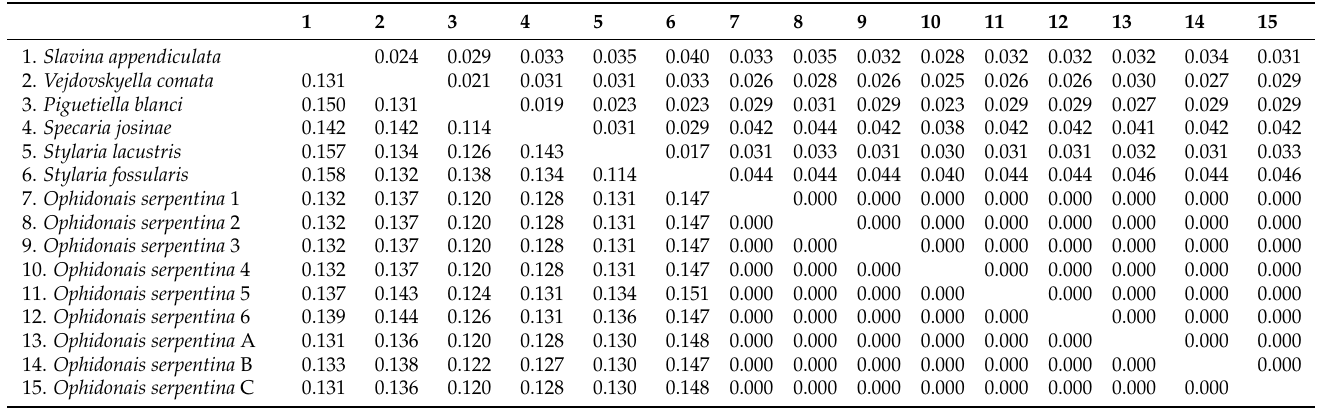
Table 4. Genetic distances of O. serpentina with allied species (15 sequences) based on 16S gene (up) and COI gene (down).